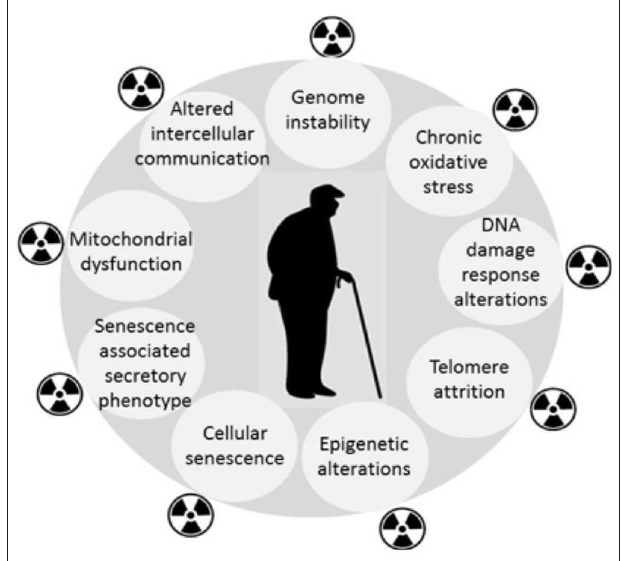
FIGURE 1 | RT amplifies processes reminiscent the biological hallmarks of